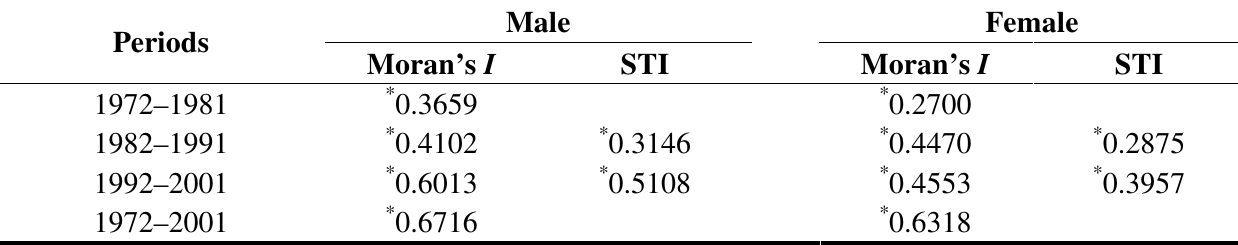
Table 1. Global Moran’s I and space-time Moran’s I (STI) of OC mortality rates, 1972–2001. Periods